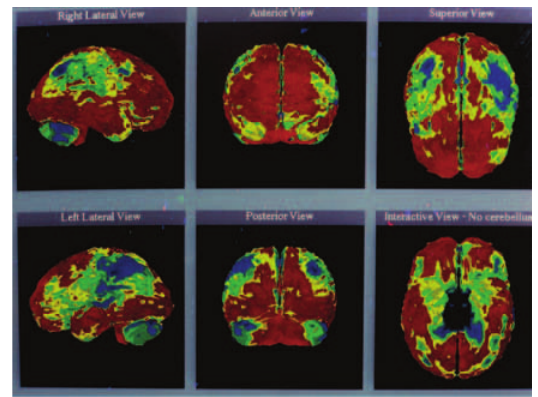
Figure 2. 99 m Tc-HMPAO SPECT